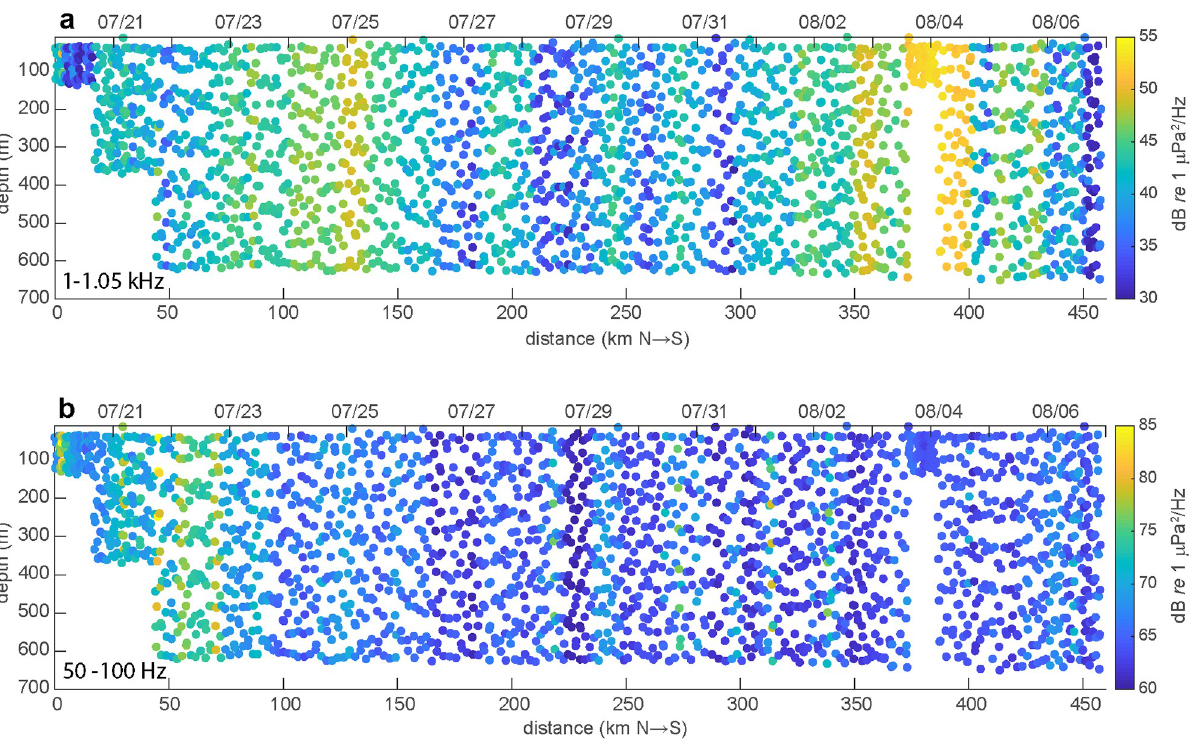
Fig 8. 2-D scatter maps showing ambient conditions along the continental shelf break from the glider’s north to south progression. The (a) wind dependent frequency band and (b) ship noise band. Noise levels are calculated from 10 minute averages and the data during the mission along the glider track is shown on the upper x-axis. Note the change in energy scale between the upper and lower figures.